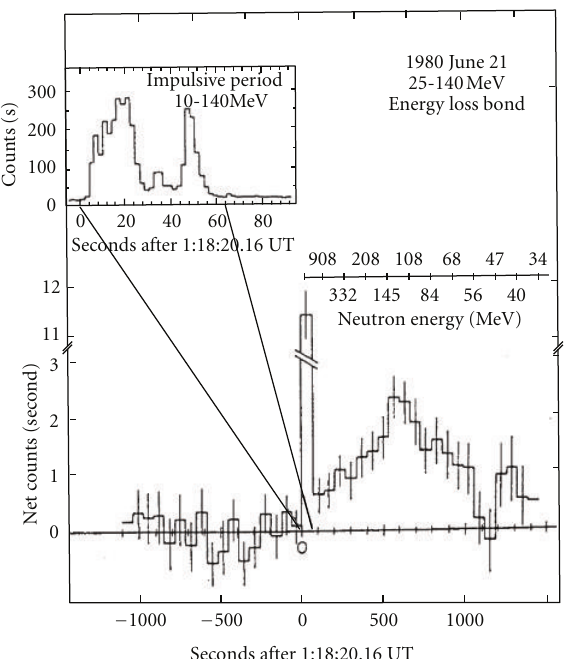
Figure 1: Solar neutrons detected on June 21, 1980. Gamma-rays accounted for the first peak; neutrons accounted for the second. The original picture was prepared by the authours of [3,